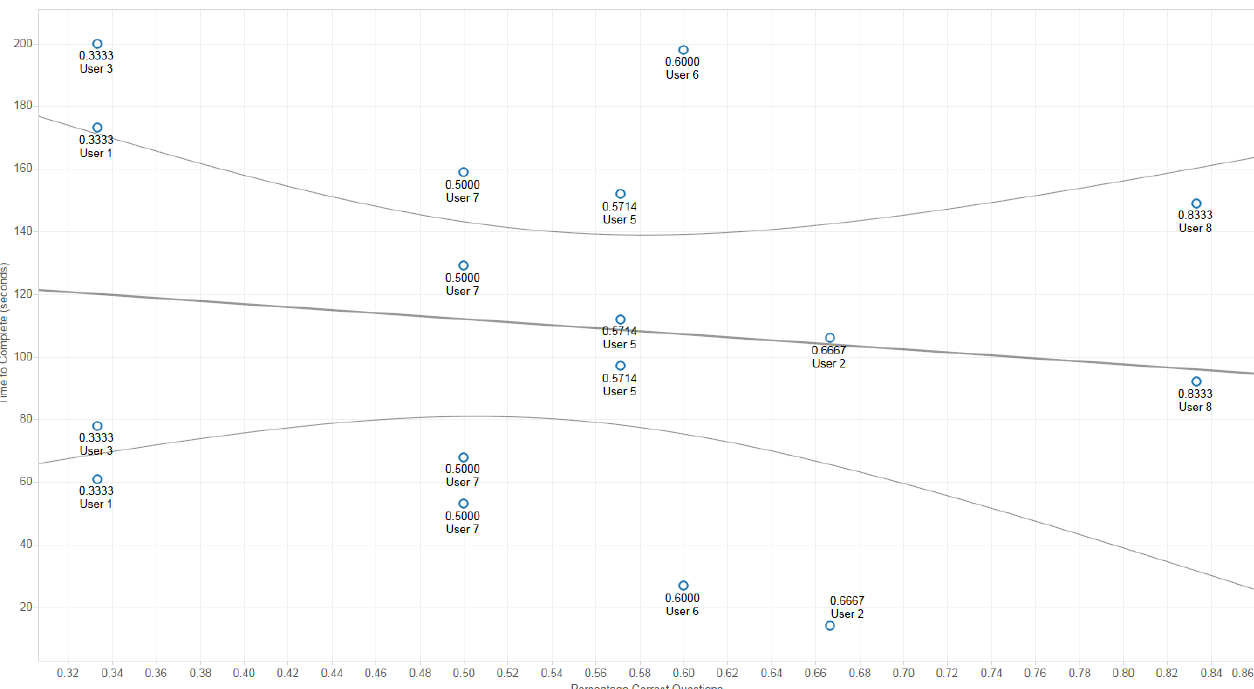
Figure 11. Relationship between the percentage of network representation questions that a user got correct and the time it took for users to answer the other questions. R-squared for this linear model is 0.017861.